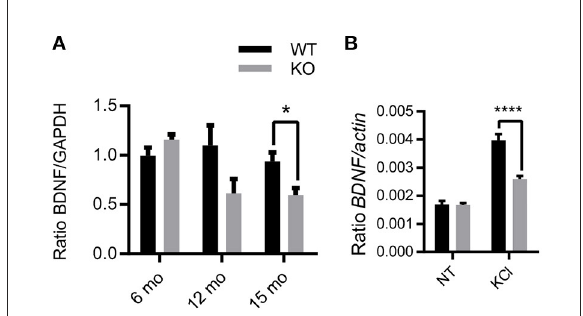
FIGURE4 Activity and age-dependent alterations in BDNF expression in ZnT3KO hippocampus. (A) Age-dependent alterations in BDNF protein levels were assessed in hippocampus tissue from age-matched WT and ZnT3KO mice by Western blot analysis, finding that ZnT3KO hippocampus has an age-dependent decrease in BDNF protein levels, becoming significant by 15 months of age. (B) Activity-dependent increase in BDNF mRNA was assessed through RT-PCR and qPCR analysis in acute hippocampal slices from 3-4-week-old WT and ZnT3KO after 3.5-h incubation in 20mM KCl. WT, wild type; KO, ZnT3KO; BDNF immunoblots, 6 mo, n = 6; 12 mo, n = 5; 15 mo, n = 6; BDNF mRNA, n = 4; NT, no treatment (vehicle); KCl, 3.5h incubation in 20mM KCl, n = 6; * p < 0.05, **** p < 0.0001; immunoblot values expressed as normalized densitometry relative to GAPDH; BDNF mRNA values expressed as fold change ratio to actin. Data were analyzed by two-tailed unpaired t -test. Error bars indicate the mean ±